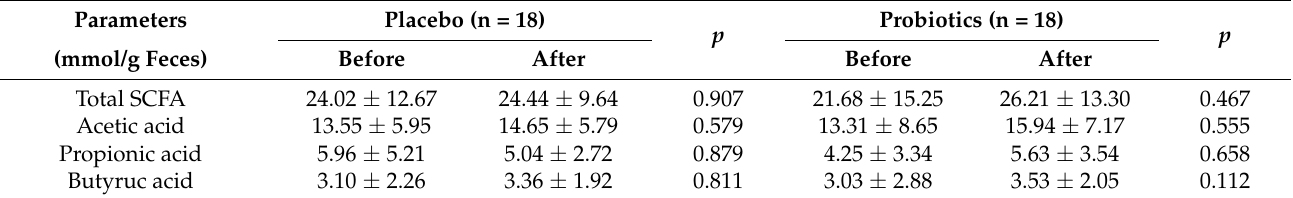
Table 5. SCFAs of feces.